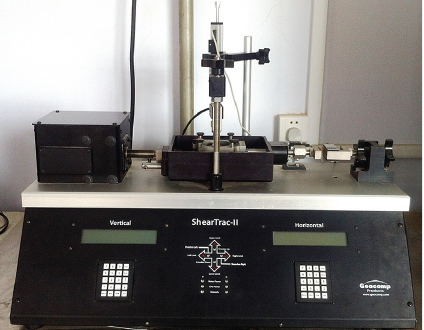
Figure 4: Direct/residual shear test apparatus (ShearTrac II).